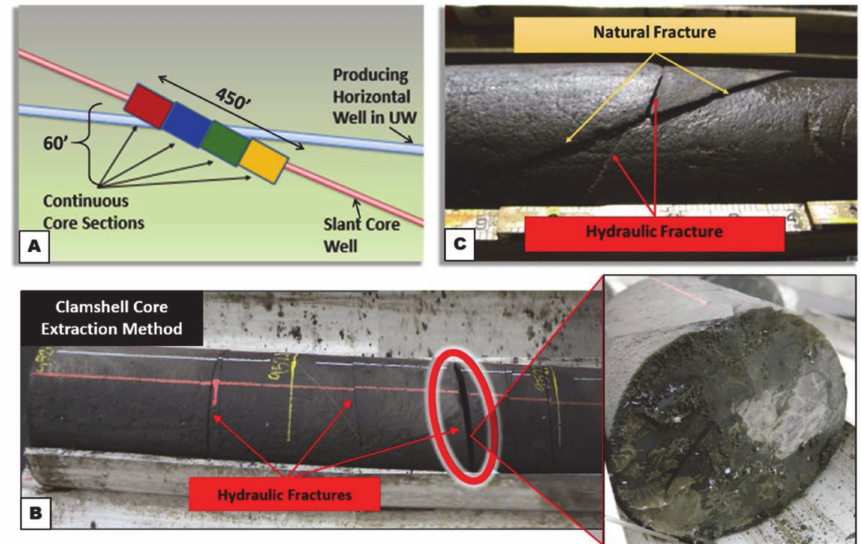
Figure 4. ( A ) Depiction of the continuous core sections collected adjacent to the stimulated producing Upper Wolfcamp well. ( B ) Example of a whole core interval. Hydraulic fracture shown in right panel. ( C ) Examples of a hydraulic fractures cutting a natural fracture captured in the core (from